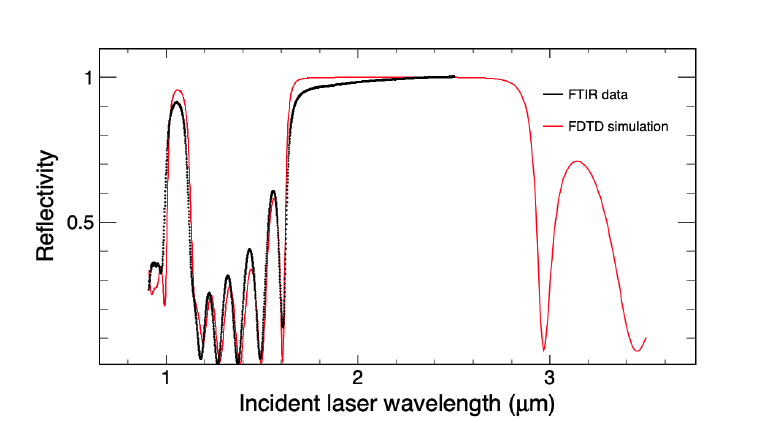
Figure 19. Reflectivity of a distributed Bragg reflector structure used to enhance the efficiency of sensors sensitive at 1550 nm. Data are shown in black and the FDTD simulation is in red.